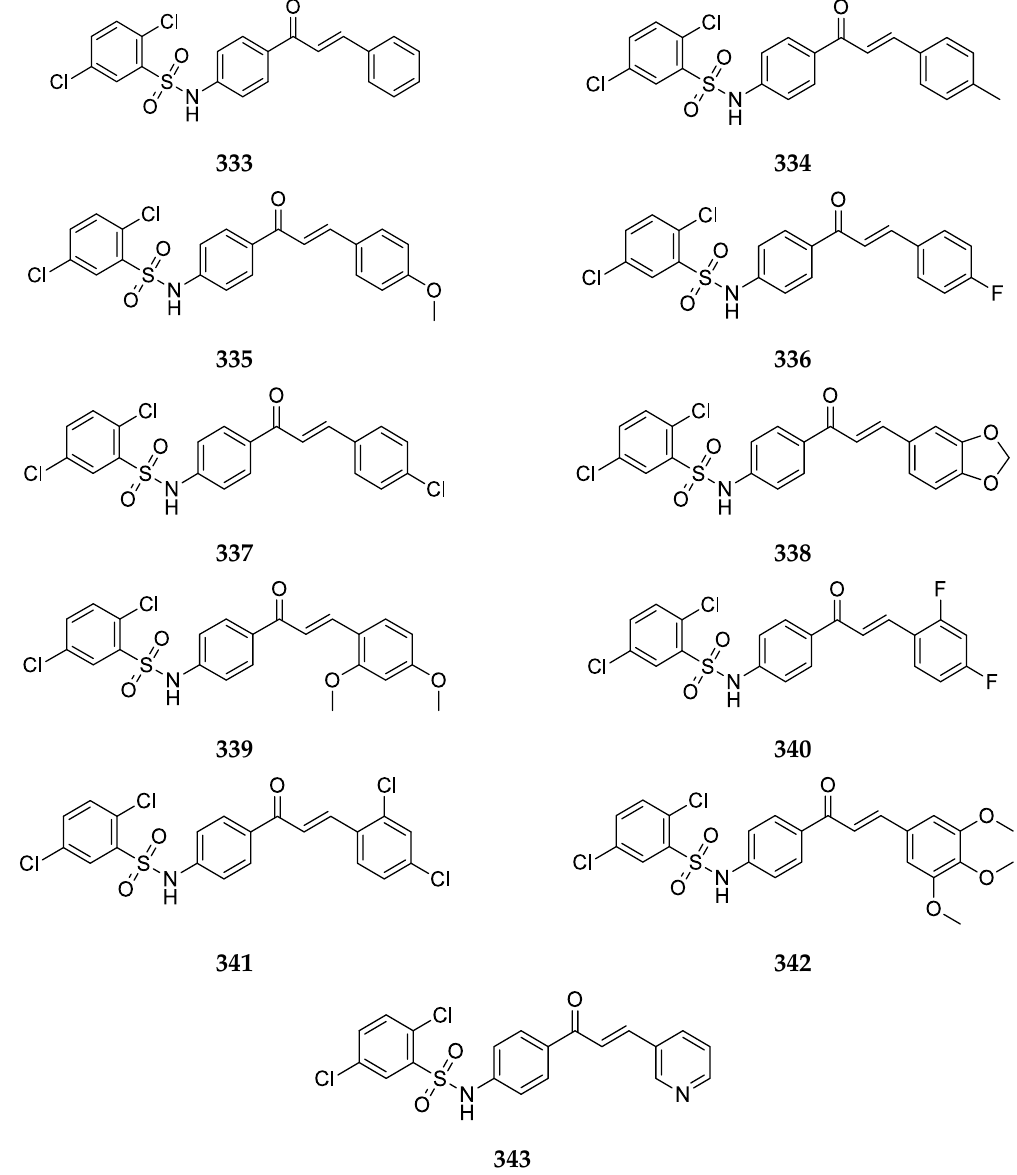
Figure 84. Chemical structure of sulfonamide-4-aminochalcone derivatives with substitution on ring